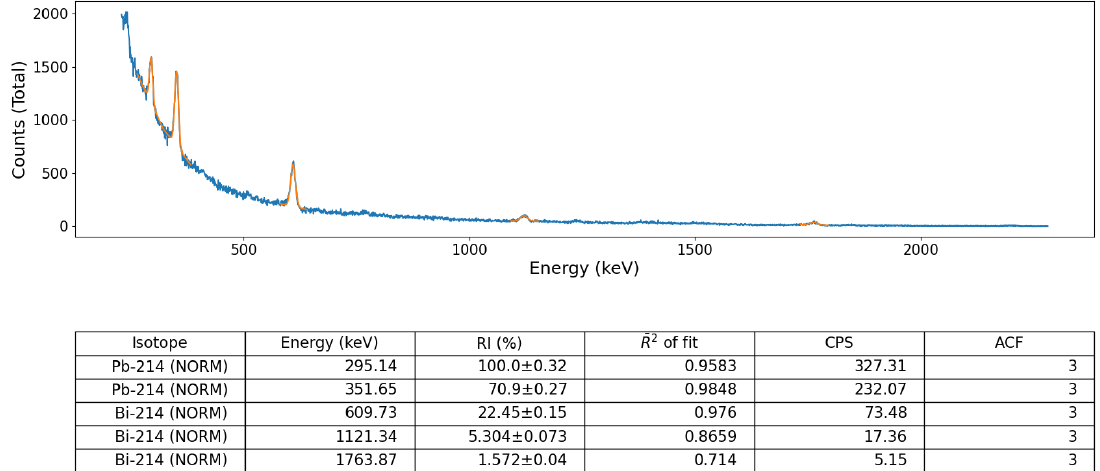
Figure 5. Peak-identified gamma-ray spectra, analysed after data collection (post-processed), for a NORM source. The table of isotopes includes: a RI for each peak, based on the integrated counts under the peak; an adjusted R 2 as the goodness of fit test for the modeled Gaussian distribution; a value for the integrated CPS under the peak and an ACF for the assigned isotope from 1 to 3. The duration of data collection was 5 min